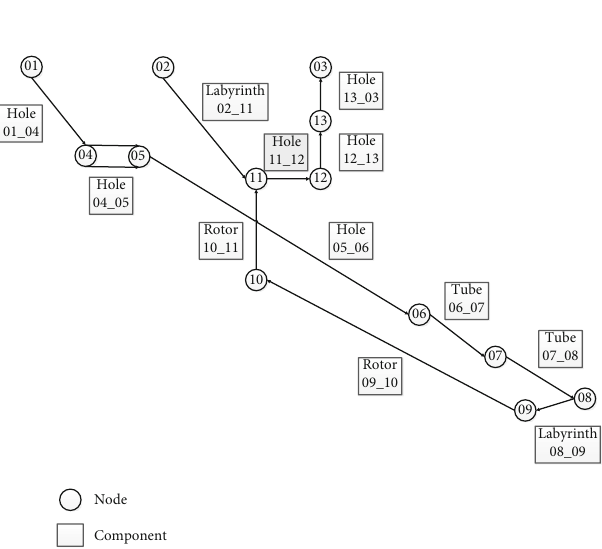
Figure 5: Flow path in the high-pressure unloading